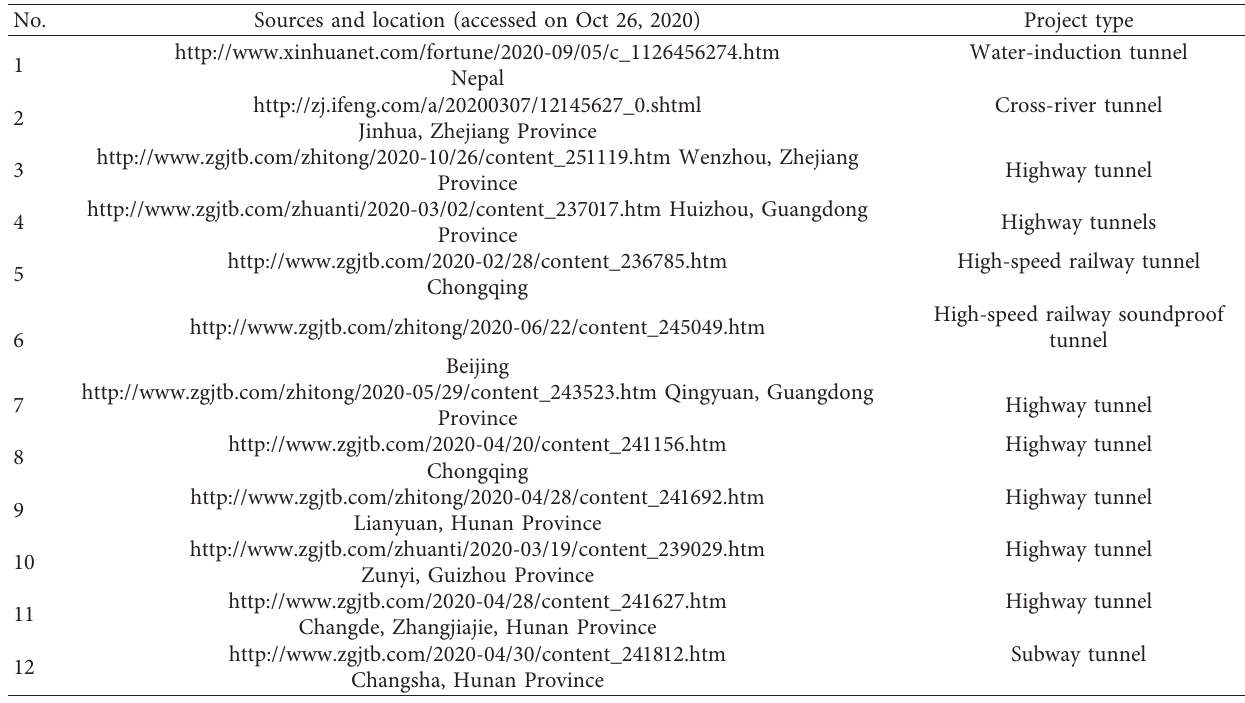
Table 1: Cases outline.